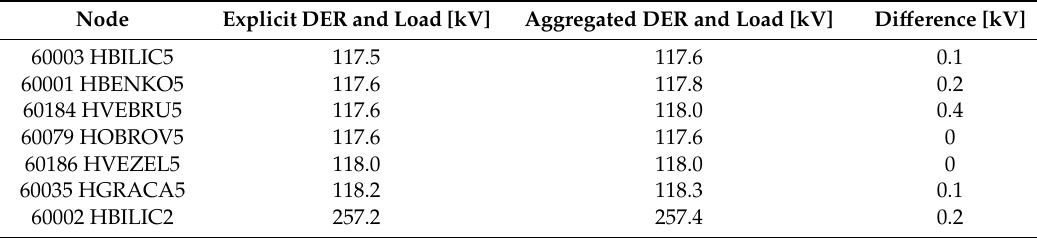
Figure 6. Calculated power flow and voltages of analyzed power transmission system–aggregated DER and load–downstream load flow. Table 4. Node voltage comparison